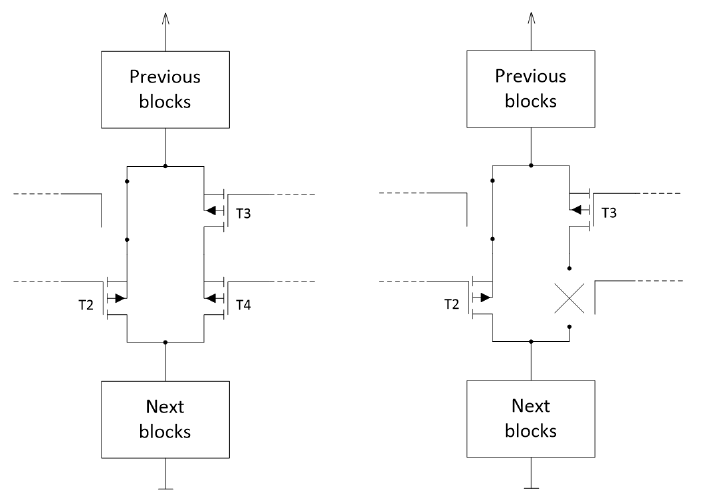
Figure 10. Fault-tolerant switching element with redundant